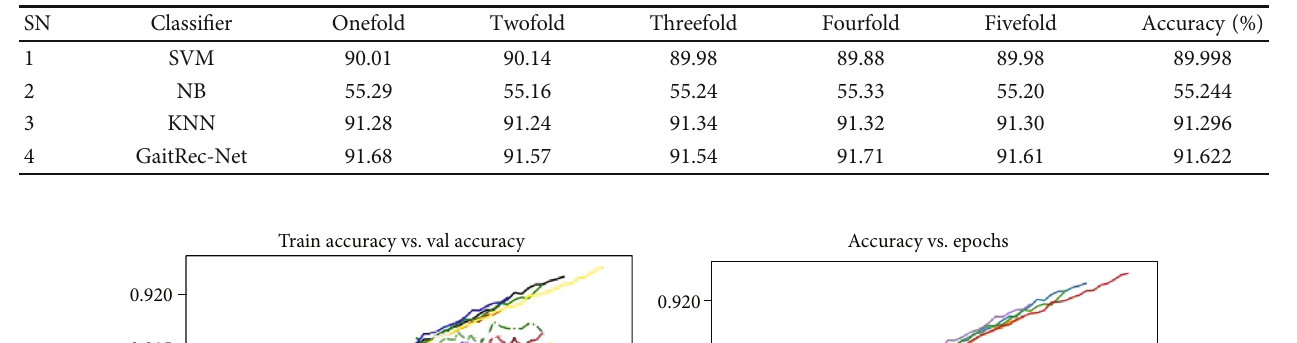
Table 8: The average accuracy of classi fi ers at each fold.